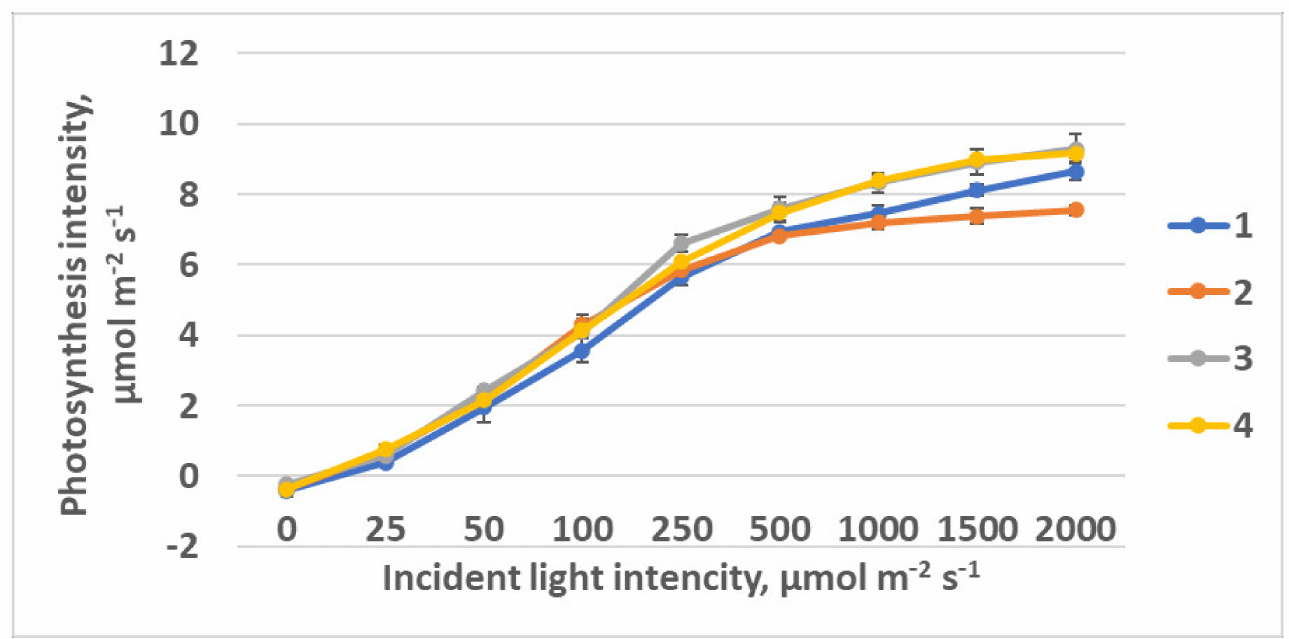
Figure 5. Light response curves of raspberry plants grown under different red (R 660 )–far-red (FR)light ratio. Means ± standard error (SE). Treatment 1—0% R 660 + 100% FR; Treatment 2—30% R 660 + 70% FR; Treatment 3—70% R 660 + 30% FR; Treatment 4—100% R 660 + 0% FR. Table 1. Light response curve parameters in raspberry plants grown under different red (R 660 )–far-red (FR) light ratio. Means ± standard error (SE); means followed by the same letter were not different at p ≤ 0.05. Parameters Light Treatment